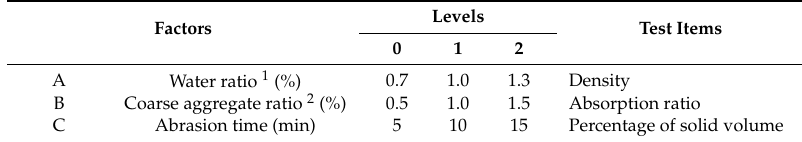
Table 1. Experimental plan using the design of